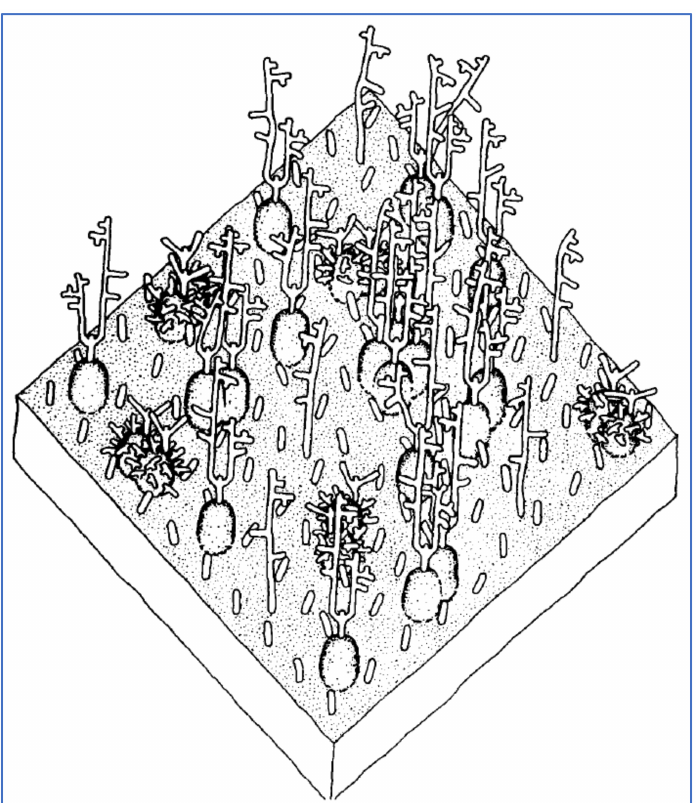
Figure 5. A representation of a 350 × 350 Angstrom area of the RBC surface depicting its sialogly- coprotein coating, consisting of GPA molecules, extending approximately 5 nm from the RBC cell membrane, plus other smaller glycoprotein molecules interspersed. Reproduced with permission from Elsevier (Viitala, 1985